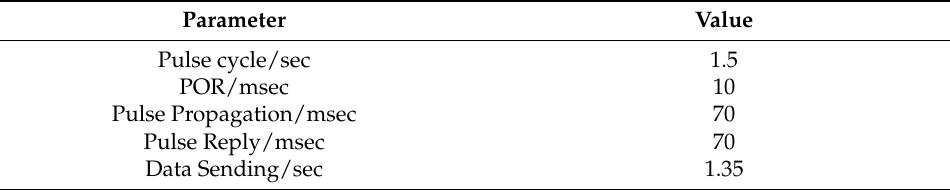
Table 2. Protocol